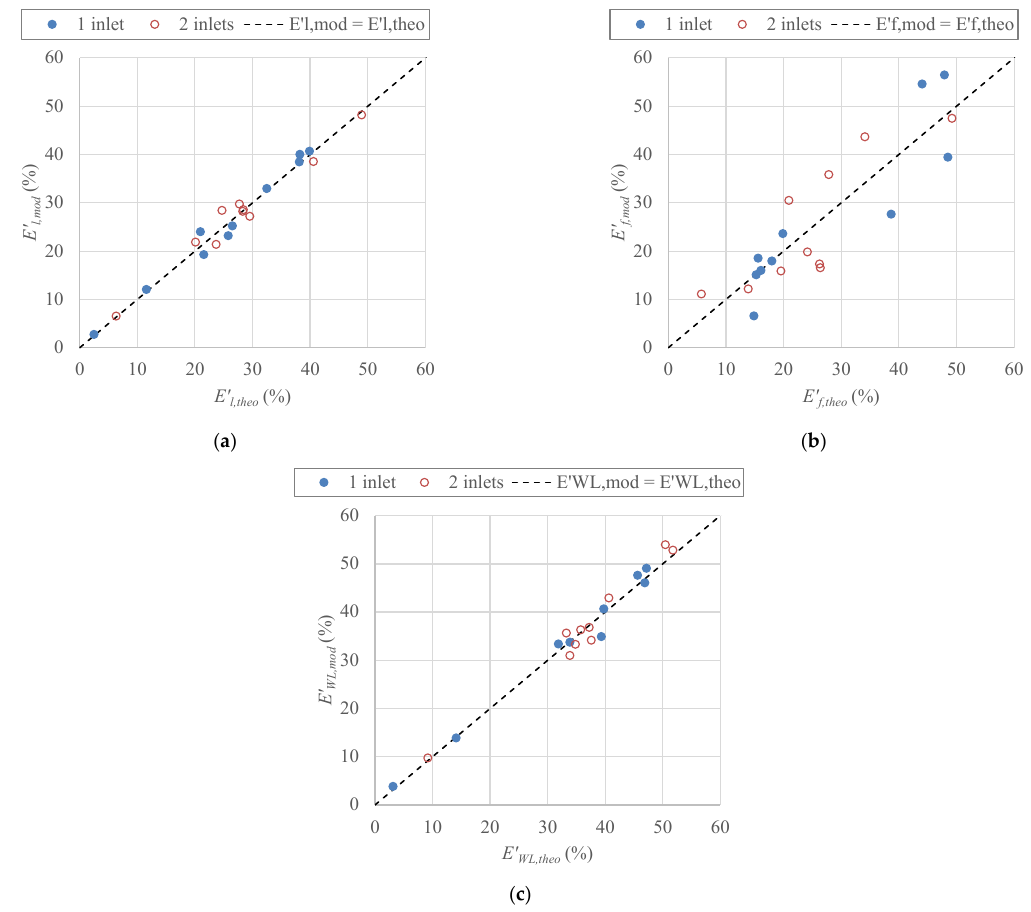
Figure 7. Comparison between energy balance components calculated by EPANET models and ones estimated by theory, where ( a ) E (cid:48) vs. E (cid:48) , ( b ) E (cid:48) vs. E (cid:48) and ( c ) E (cid:48) vs. E (cid:48) . l , mod l , theo f , mod f , theo WL , mod WL , theo Table 2. Performance of proposed theoretical methods to evaluate energy balance components before and after considering normalized head loss ∆ H (cid:48) with calibrated coefficient C mj